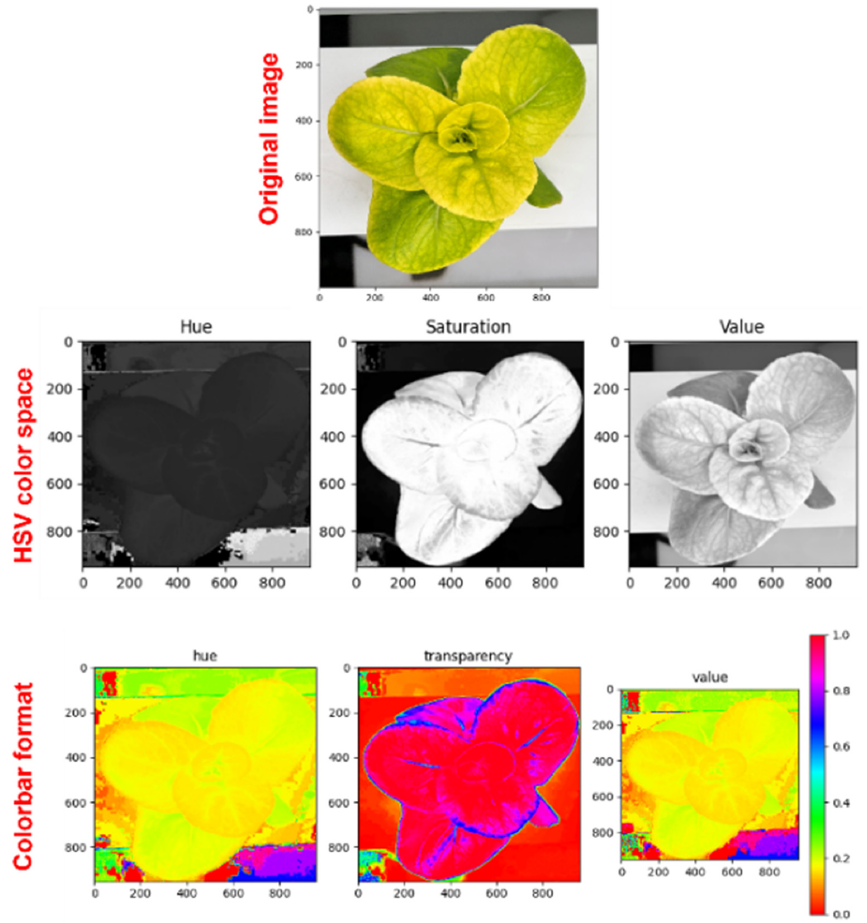
Figure 4. Illustration of image, its HSV channels, and color bar